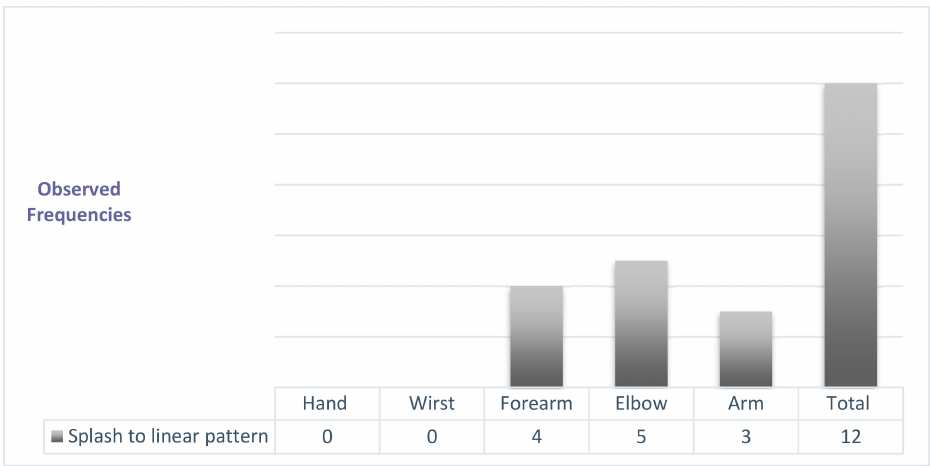
Figure 6. Modifications of the splash pattern after physiotherapy